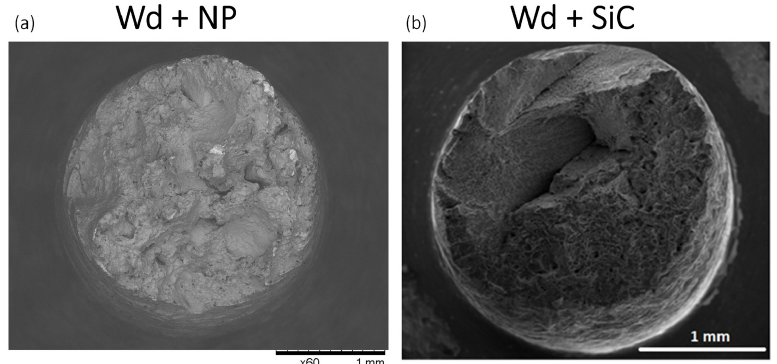
Figure 9. The fracture surface of the Ti-6Al-4V alloy creep tested at 600 °C and 125 MPa, (a) plasma nitrided (Wd + NP) and (b) SiC coated (Wd + SiC).